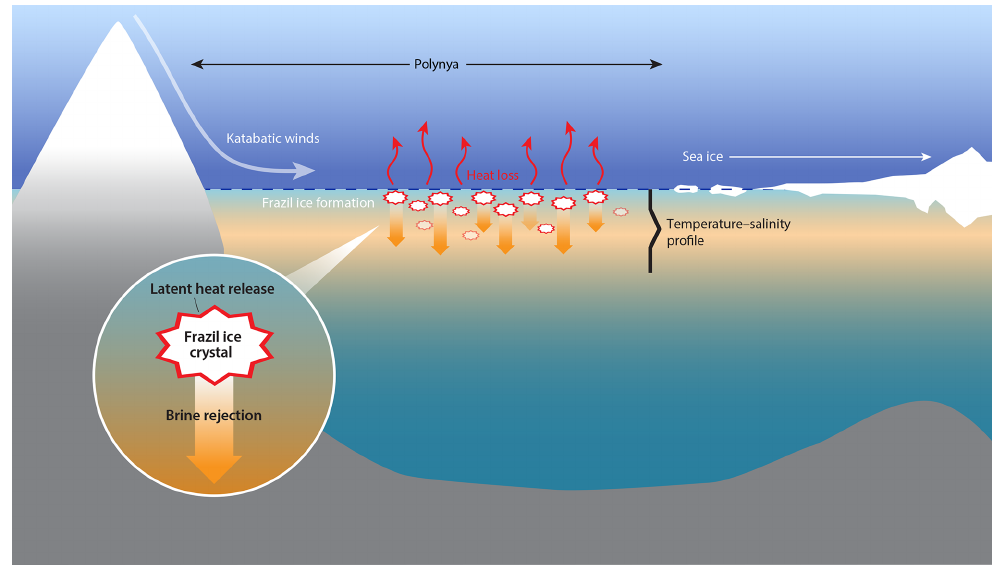
Figure 1. Schematic of a latent heat or coastal polynya. The polynya is kept open by katabatic winds which drive sea ice advection, oceanic heat loss, and frazil ice formation. Ice formation results in oceanic loss of latent heat to the atmosphere and brine rejection. The inset is a schematic of frazil ice formation that depicts the release of latent heat of fusion and brine rejection as a frazil ice crystal is